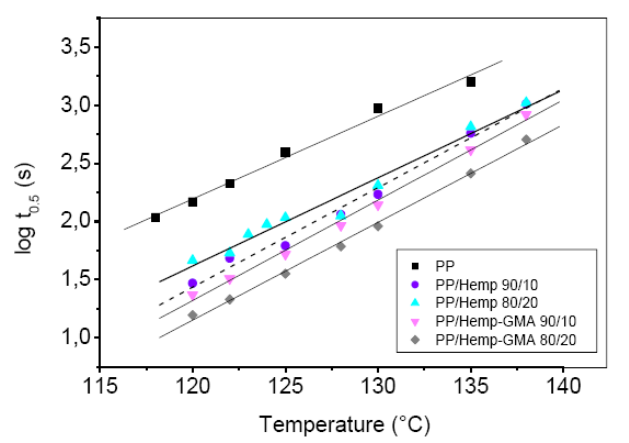
Figure 4. Temperature dependence of the crystallization half-time for PP, PP/Hemp and PP/Hemp-GMA composites isothermally crystallized from the melt.